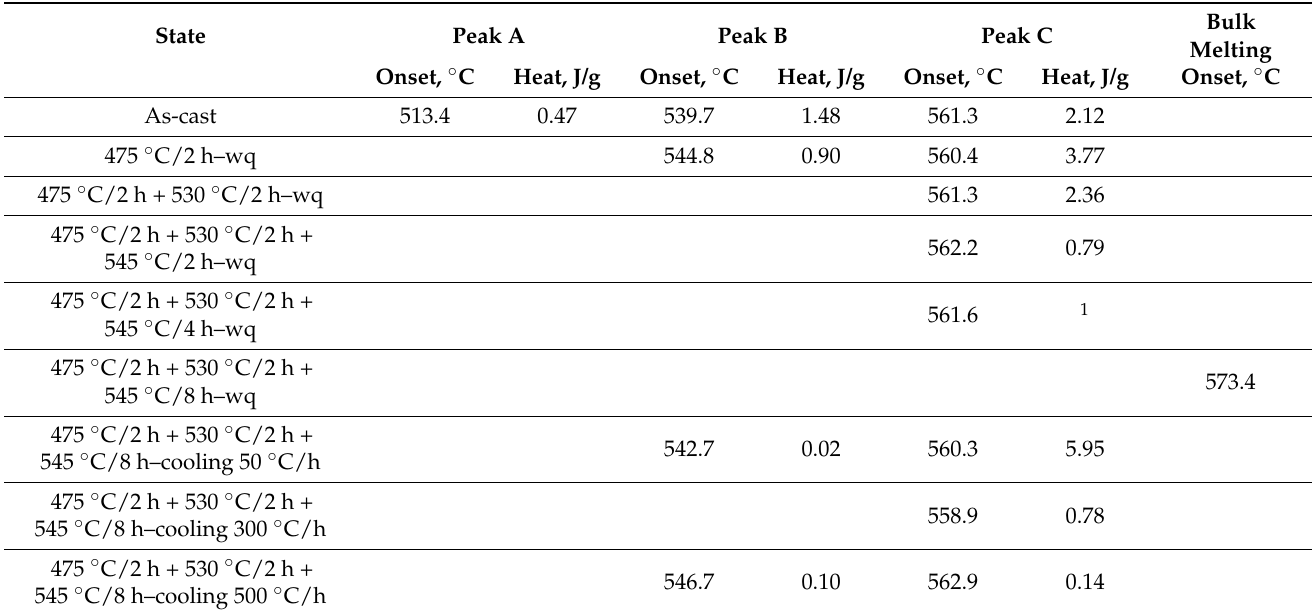
Table 2. DSC test